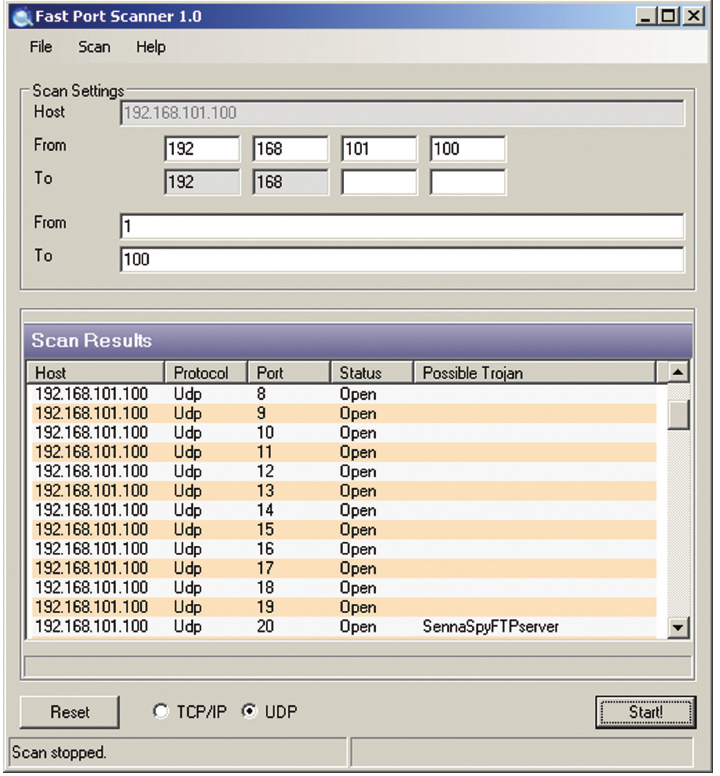
Figure 10. UDP Port Scanning Using Fast Port Scanner Tool.